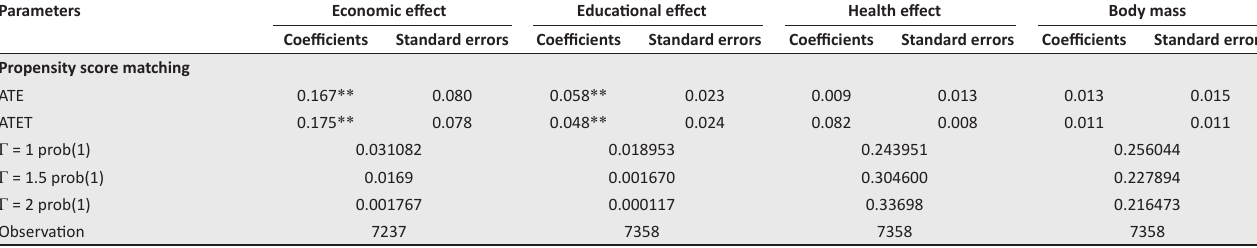
TABLE 5: Results from propensity score matching model: Effects of teen motherhood on child outcomes.